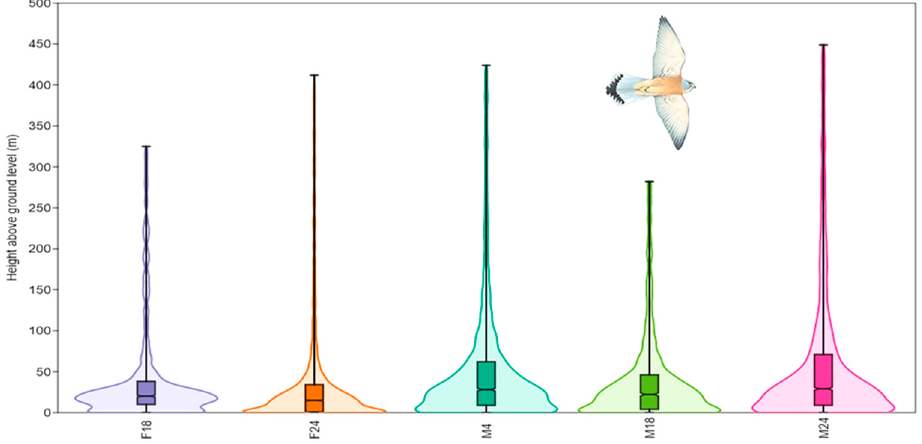
Figure 2. Tessellation (1584 squares) of the smallest possible convex polygon around the 2D home ranges (coloured polygons) of the tracked lesser kestrels. IDs are the same as those in Table 1.